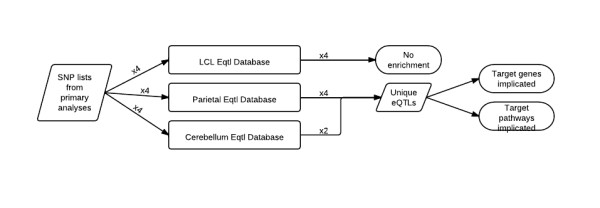
 A flowchart showing the study design. One SNP list from each of the four primary analyses in the publication from Anney et al. [6] (totaling four lists of SNPs) was annotated for eQTL information against an LCL eQTL dataset (http://www.SCANdb.org[14]), parietal tissue and cerebellar tissue. No enrichment was found in any of the LCL annotated datasets, enrichment was found in the parietal lobe for all four analyses and in cerebellar tissue for two of the datasets. The eQTL found in each of the six analyses were combined in order to identify unique eQTL signals that appeared in one or more tissues and in one or more primary analyses. This complete list of unique eQTL signals was then investigated for genes and pathways of interest in autism. eQTL: expression quantitative trait loci; LCL: lymphoblastoid cell line.